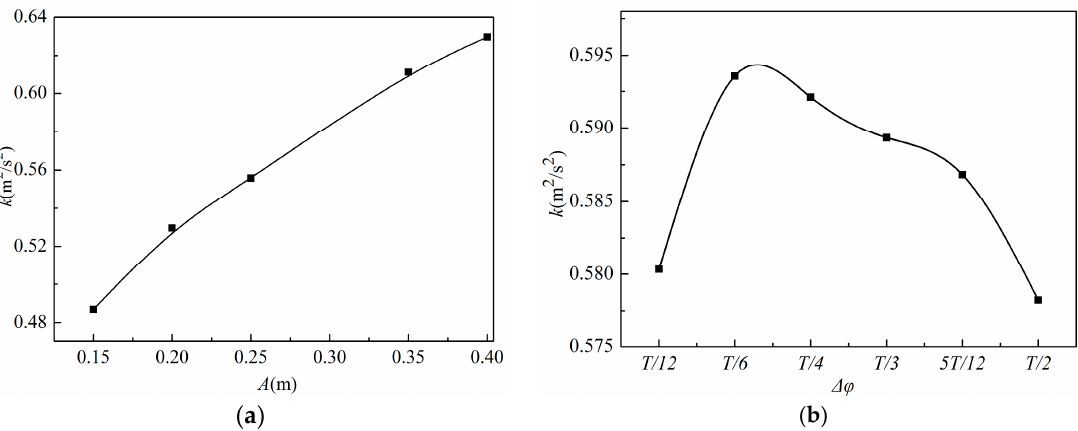
Figure 17. ( a ) Effect of amplitude on the mean k of the impingement region during one period, as determined by CFD for sinusoidal step inlet velocity, u m = 1.25 m/s, T = 0.4 s, L / D = 4 and ∆ ϕ = T /2. ( b ) Effect of phase difference, as determined by CFD, on the mean k of the impingement region in one period for sinusoidal step inlet velocity, u m = 1.25 m/s, T = 0.4 s, L / D = 4 and A = 0.25 m/s.